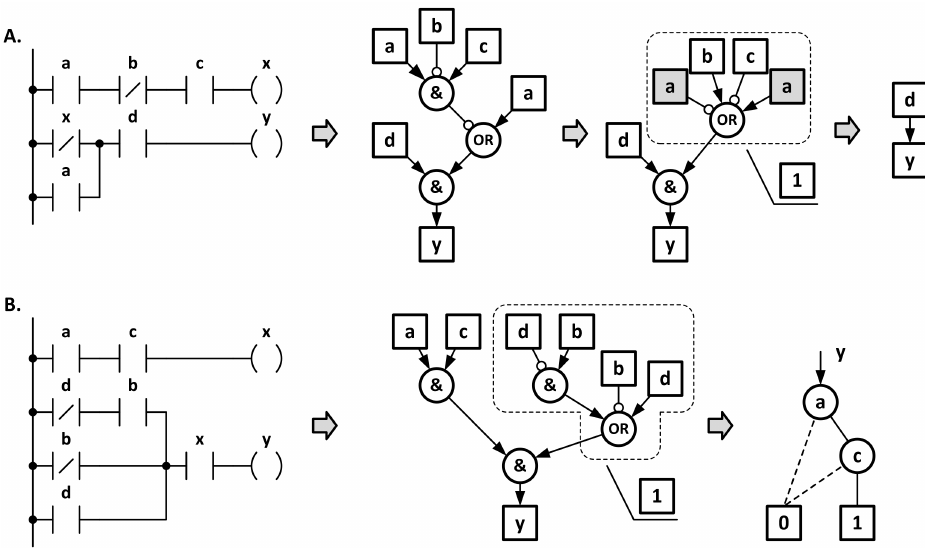
Figure 9. The logic optimization of EFG—possibilities ( A ) and limitations ( B